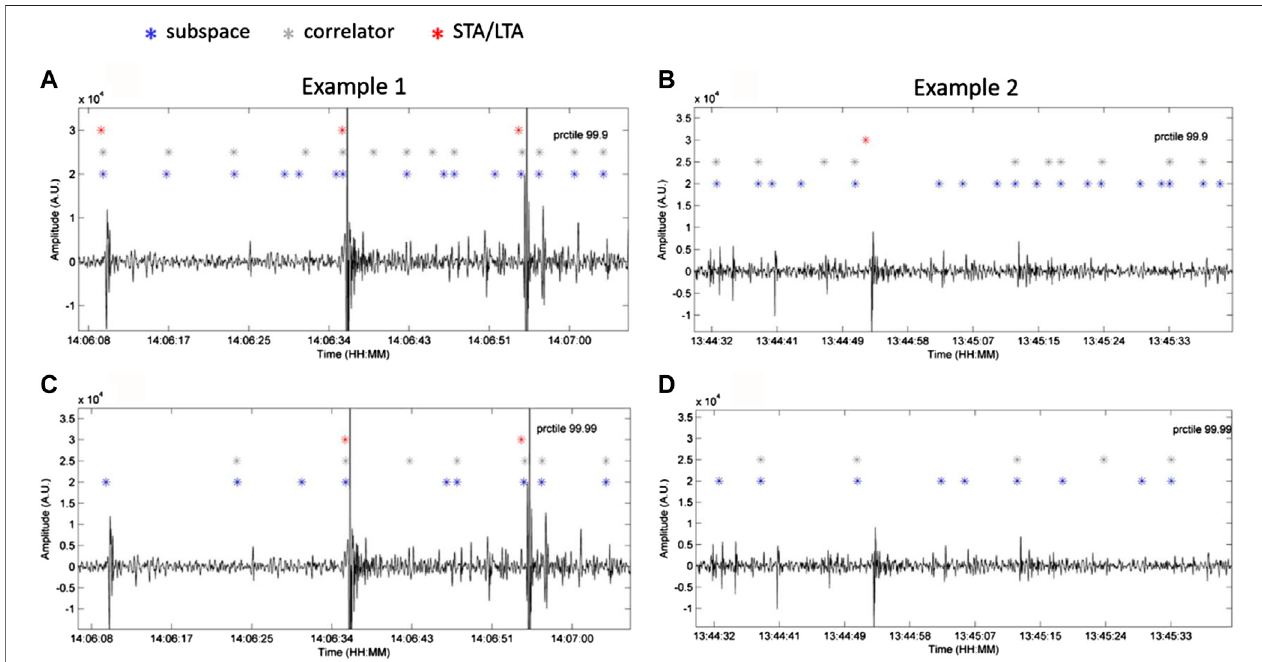
FIGURE8| Zoom inof Figure7A (example 1, A and example 2in B ) byusing 99.9as percentile and respective comparison withresults of Figure 9A using 99.99 as percentile (C,D) .